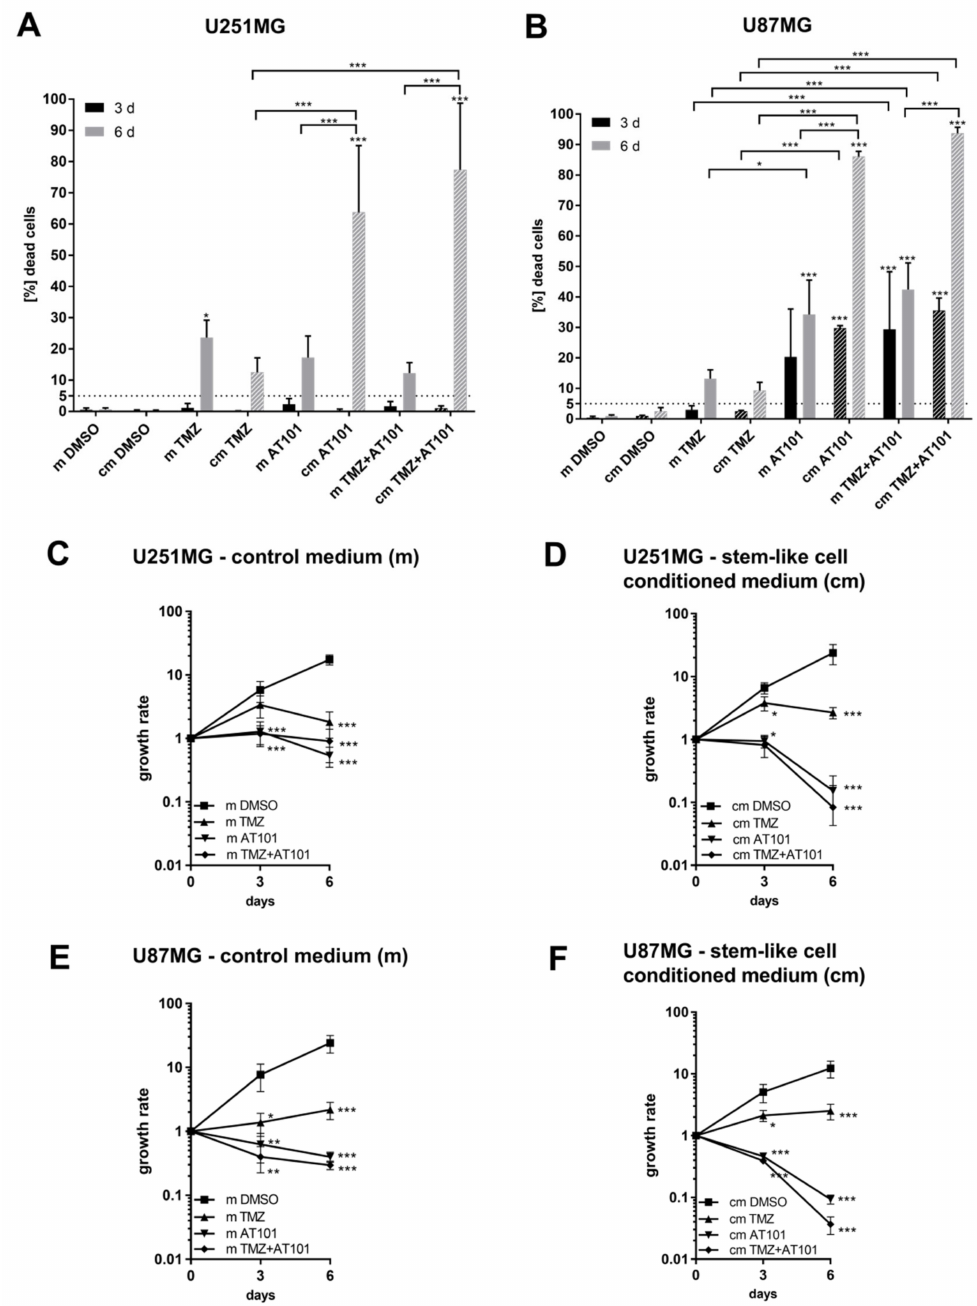
Figure 3. Stimulation with stem-like cell-conditioned media increased the effect of AT101 on the survival and proliferation of native U251MG and U87MG cells. The different cell lines were stimulated with control medium (m) and stem-like cell-conditioned media (cm) containing DMSO, temozolomide [50 µ M], AT101 [5 µ M], or a combination of temozolomide [50 µ M] and AT101 [5 µ M]. A cytotoxicity assay was carried out after three and six days, respectively, revealing death rates of native ( A ) U251MG and ( B ) U87MG cells. Cell counts were determined on days 0, 3, and 6 of stimulation. Growth rates were calculated as the n-fold number of alive cells on days 3 and 6 compared to day 0 of stimulation for both U251MG and U87MG cells incubated with ( C , E ) control medium or ( D , F ) stem-like cell-conditioned medium. The significances between different stimulation approaches were determined with a two-way ANOVA test followed by Tukey’s multiple comparison test. Significant differences compared to the DMSO control are indicated directly above the bars/directly next to the curves and between different stimulations on a line linking the bars/the curves (* p < 0.05; ** p < 0.01; *** p < 0.001). Error bars correspond to the standard deviation, n =